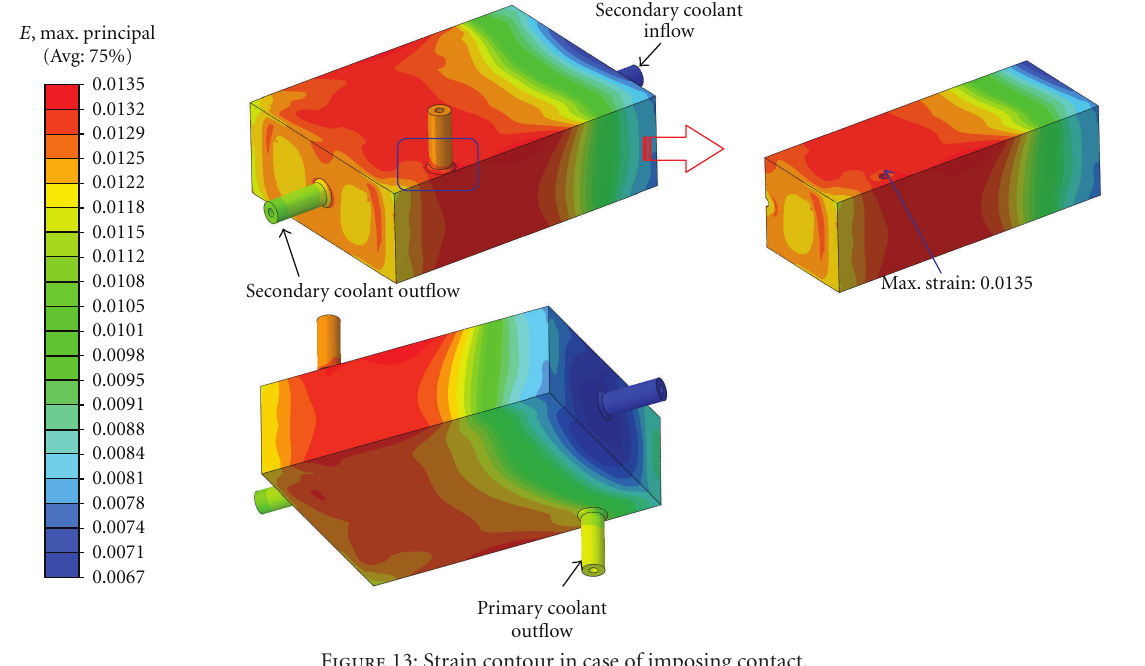
Figure 13: Strain contour in case of imposing contact.